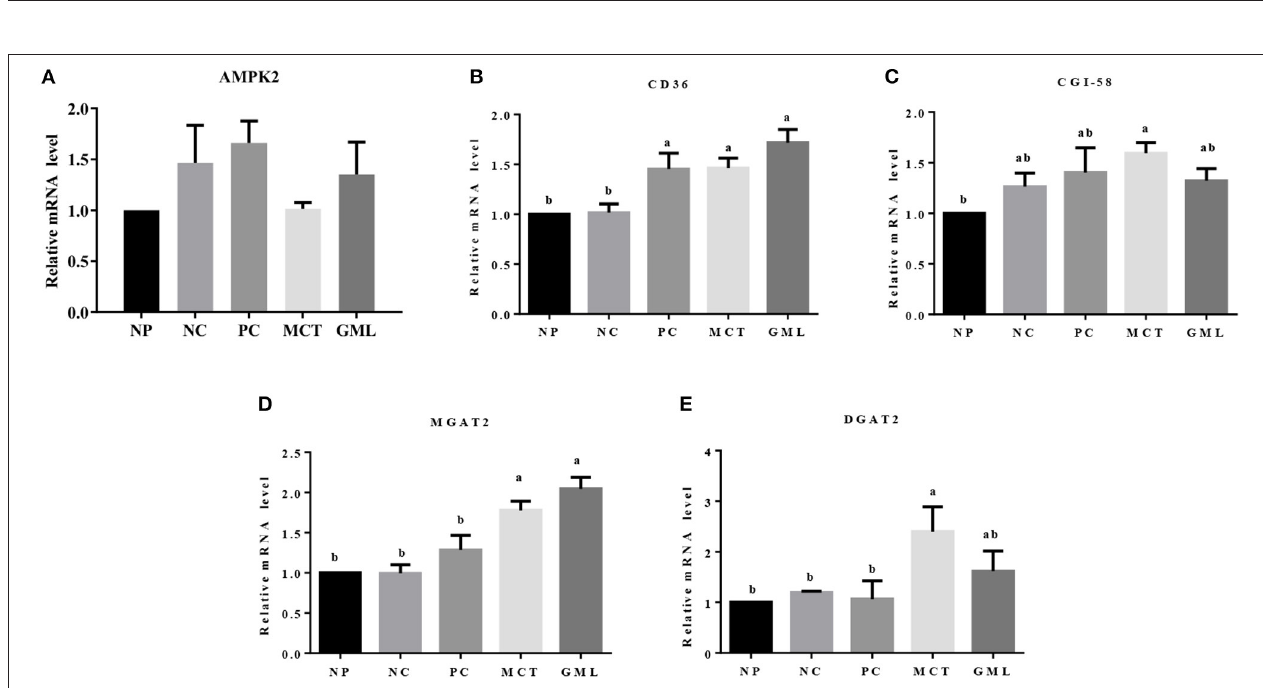
FIGURE 6 | (A–E) The mRNA expressions of genes associated with lipid sensing in the subcutaneous adipose tissue. a − c Mean values sharing different superscripts within a row differ ( P < 0.05). Values are the mean ± SEM, n = 6. NP, normal protein basal diet no antibiotics included; NC, low-protein basal diet no antibiotics included; PC, low-protein basal diet + antibiotics (75 mg/kg quinocetone, 20 mg/kg virginiamycin and 50 mg/kg aureomycin); MCT, low-protein basal diet + 2 kg/T tricaprylin/tricaprin; GML, low-protein basal diet + 2 kg/T glycerol monolaurate.